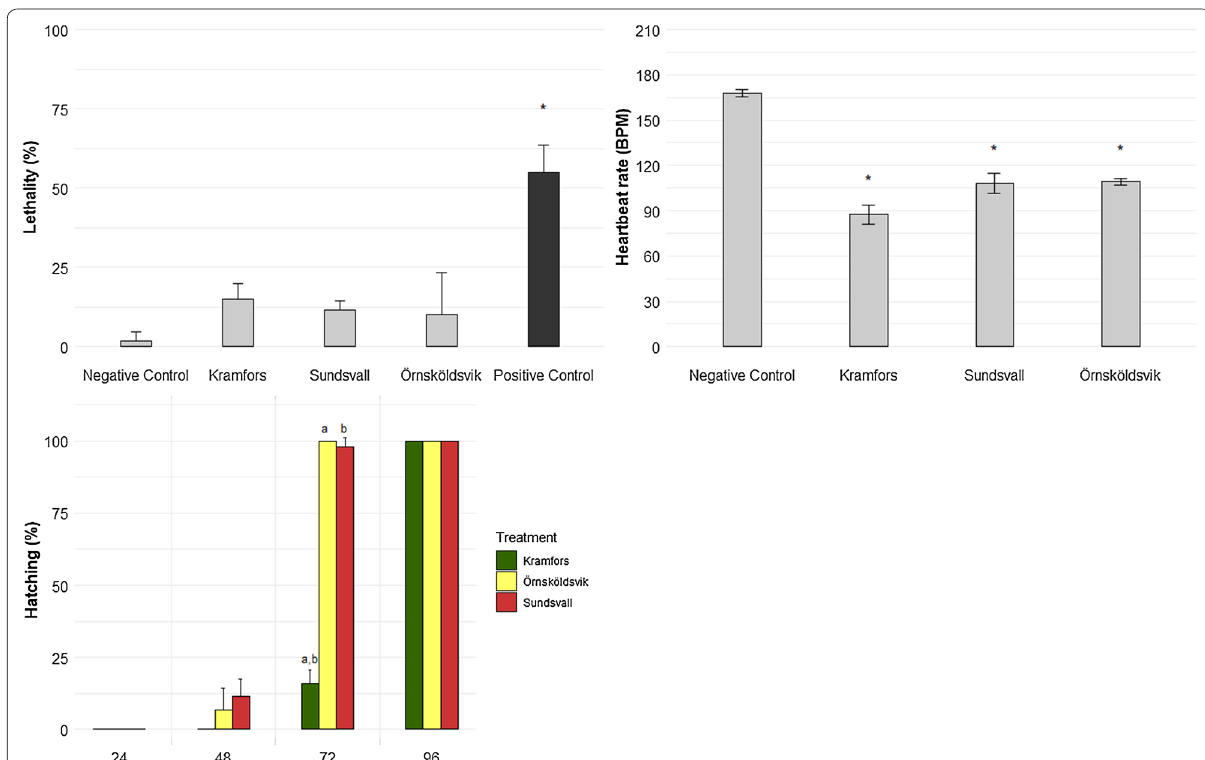
Fig. 2 Embryo toxicity ( a ), heart beat ( b ) and cumulative hatching ( c ) of Danio rerio embryos after exposure to native sediments of Gulf of Bothnia. Experiment was performed in 3 independent replicates (20 embryos). ISO-Water was used as negative control and 3,4-dichloroaniline was used as positive control (3.4 mg/L). The symbol * indicates a statistical difference between treatments or between treatments and the control ( p symbols a and b indicates a statistical difference between treatments ( p